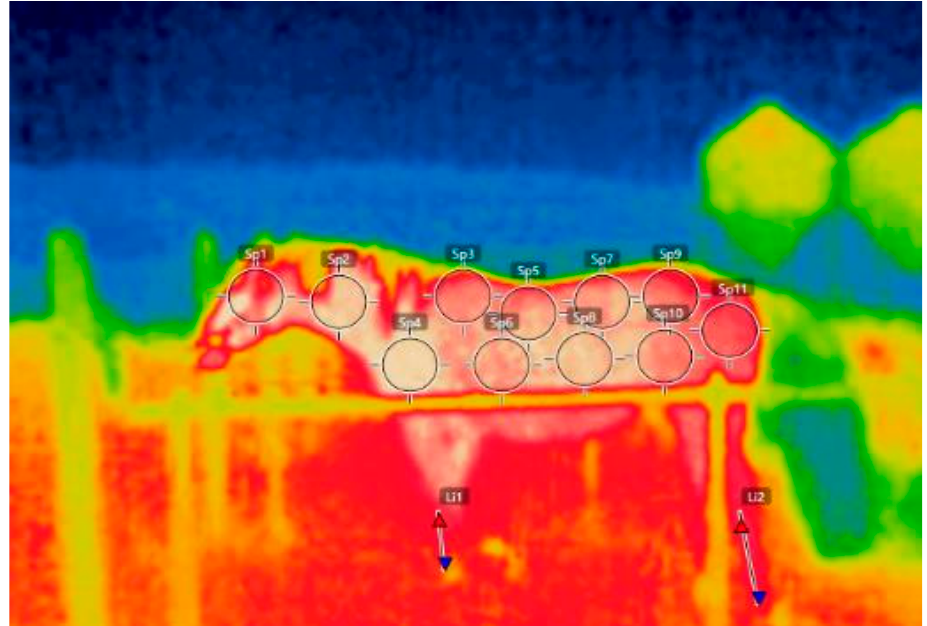
Figure 4. The 13 body sites; (SP1; head, SP2; neck, SP3; withers, SP4; shoulder, SP5; front back, SP6; front abdomen, SP7; rear back, SP8; rear abdomen, SP9; loin, SP10; thigh, SP11; buttock, li1; fore-cannon, Li2; rear-cannon).